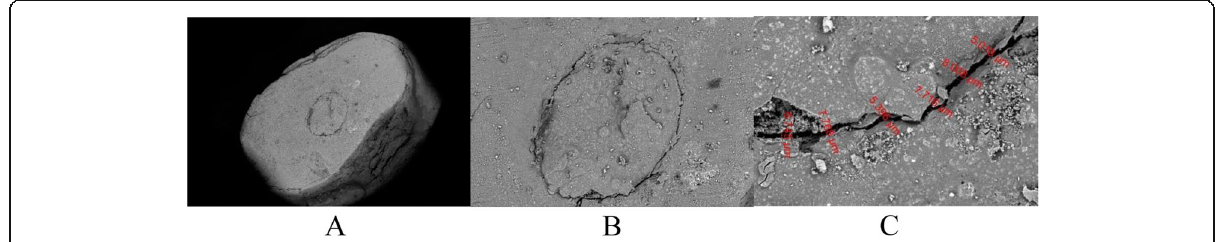
Fig. 3 SEM images of nano-WMTA. a × 50. b × 250. c × 1000